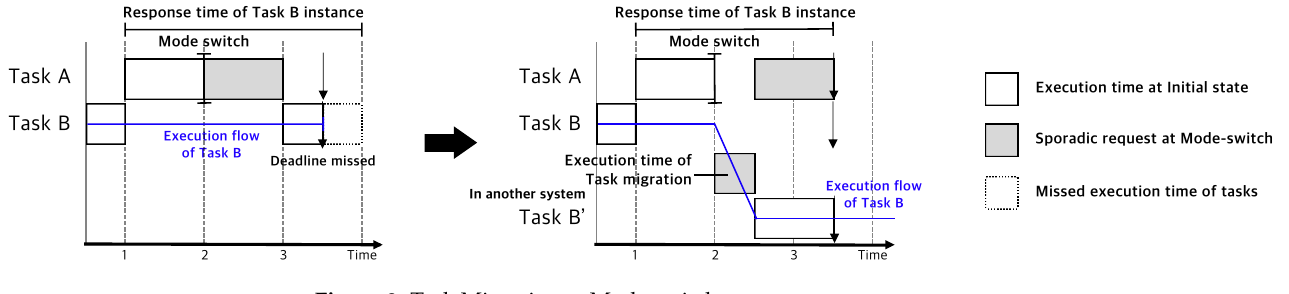
Figure 3. Task Migration at Mode